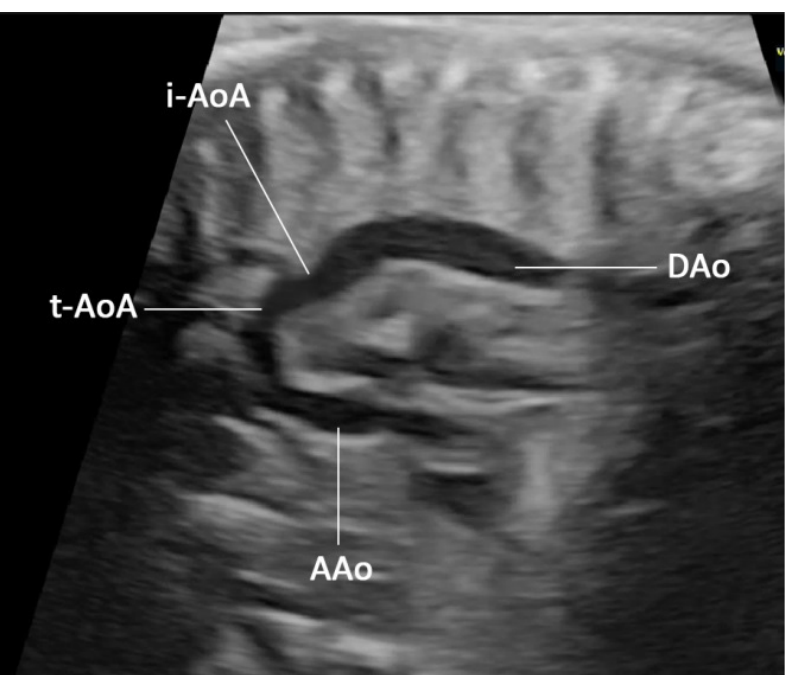
Figure 1. Prenatal ultrasound, sagittal scan, or long-axis view of the aorta shows a small aorta arch (tubular hypoplasia) connecting to the descending aorta with shelf appearance. (AAo: ascending aorta; i-AoA: isthmic aortic arch; t-AoA: transverse aortic arch; DAo: descending aorta).